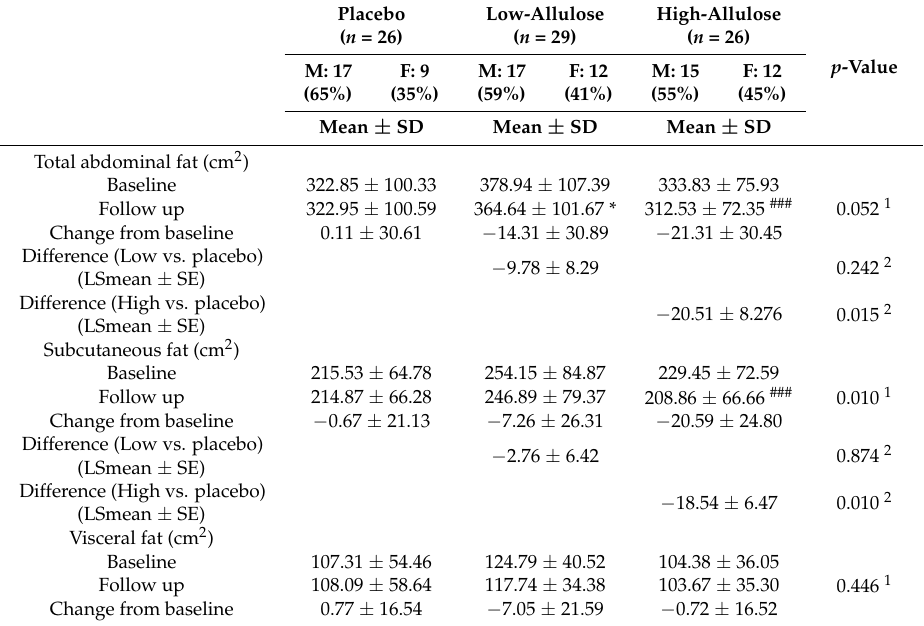
Table 5. Dose-dependent effect of D -allulose supplementation for 12 weeks on abdominal fat area assessed using computed tomography (CT) in overweight or obese